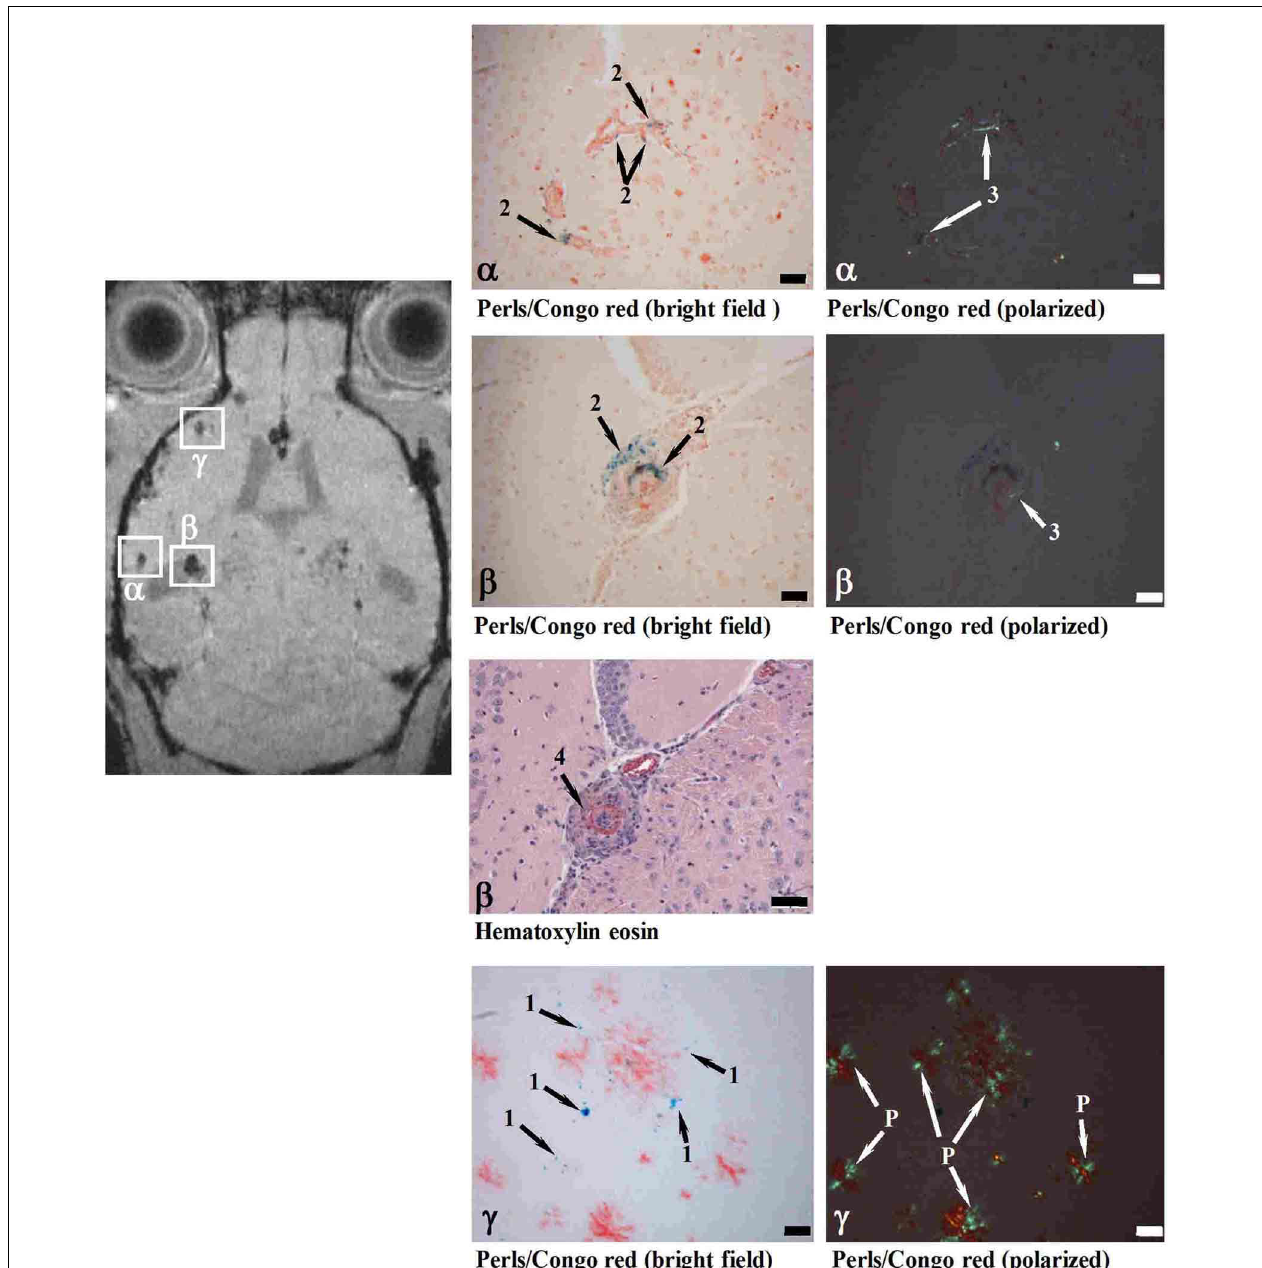
FIGURE 8 | MRI detection of CAA-related microvascular alterations utilizing superparamagnetic iron oxide (SPIO) particles. Histological examination of cerebral cortex sites with foci of attenuated MRI signal ( α , β , γ ). At 24h following SPIO administration, a male 28-month-old APP23 mouse was analyzed in vivo by MRI and processed for histology immediately thereafter. Perls/Prussian blue staining showed iron-loaded macrophages in CAA-laden vessels (Congo red positive) at both sites ( α and β ). While the vessel walls